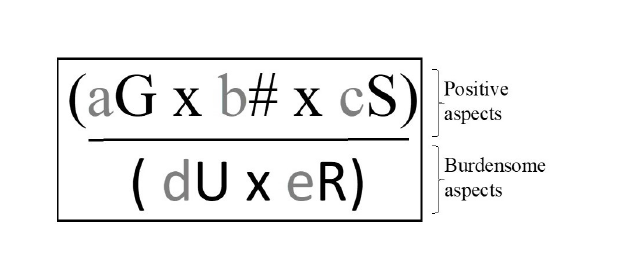
Figure 1. Equation to determine the balance of potential positive impact versus burden associated with different forms of benefit-sharing. Letters a-e represent the average weight assigned by interviewees to the five benefit-sharing factors. Benefit-sharing factors: G= biodiversity goals; # = direct beneficiaries; S = benefit-sharing significance; U = burden on the user, and; R = burden on the